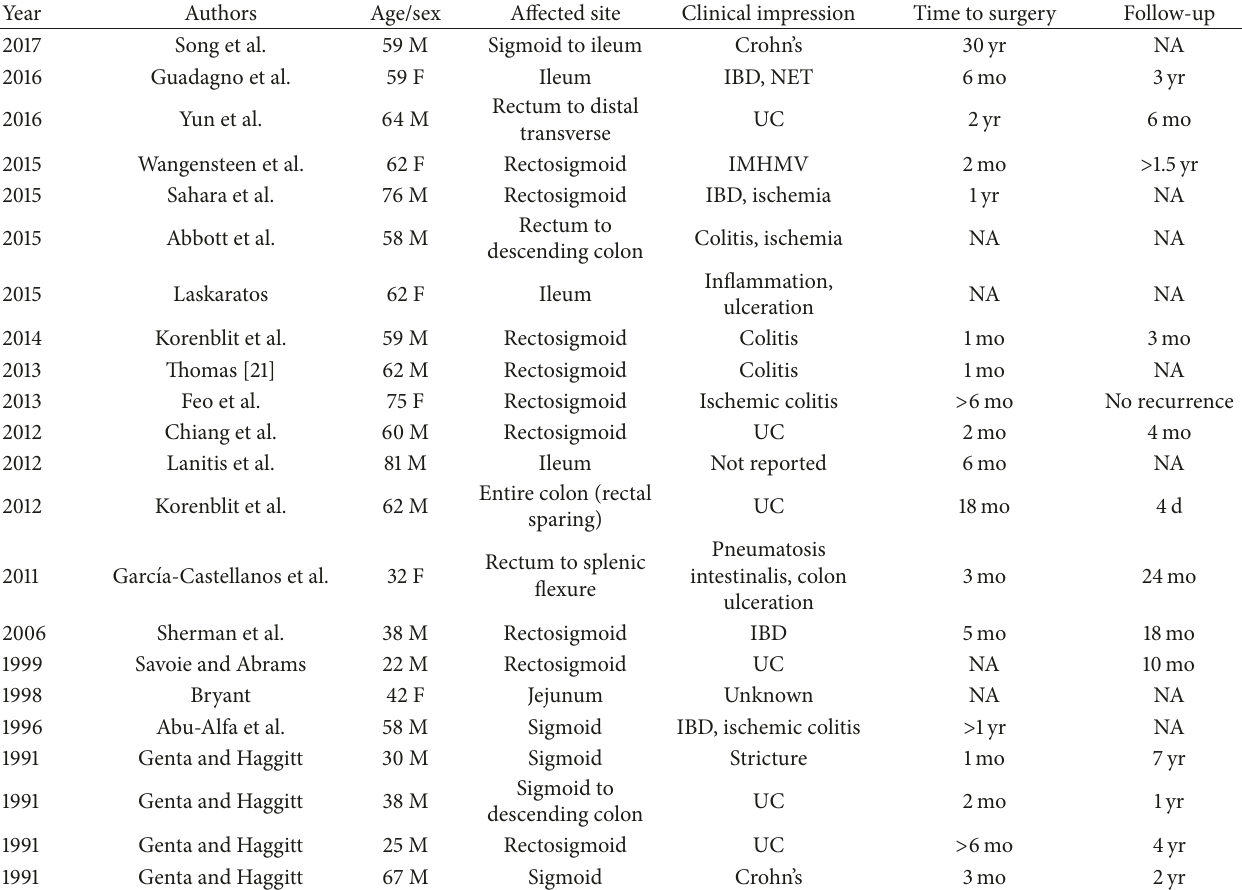
Table 1: Reported features of Idiopathic myointimal hyperplasia of mesenteric